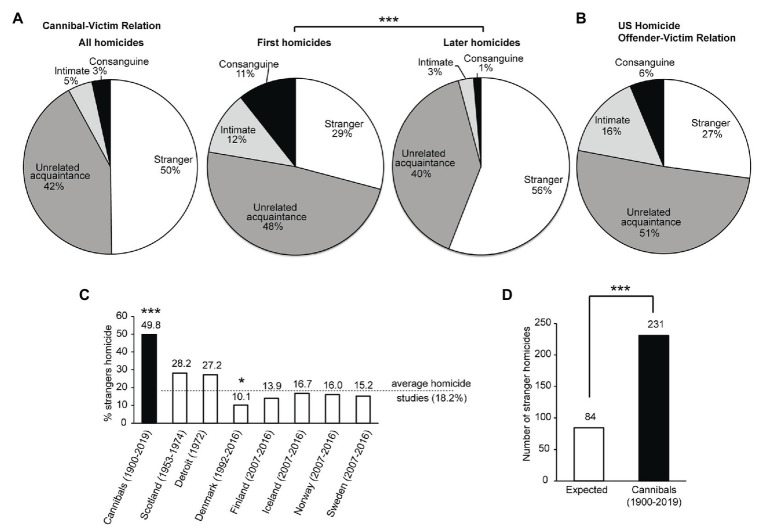
Offender-victim relationships of cannibalistic homicides and other homicides. (A) Offender-victim relationships in homicides of cannibalistic offenders, for all their homicides, only their first homicides, and the later homicides. There is a difference in offender-victim relationship between the first and later homicides [X
2(3) = 42.94, p < 0.001]. (B) Offender-victim relationships in all Detroit homicides (Daly and Wilson, 1982). (C) Fraction of homicides of strangers in cannibalistic offenses (this study) and other homicide studies (Gillies, 1976; Daly and Wilson, 1982; Lehti et al., 2019; Thomsen et al., 2019). The fraction of stranger homicides is different between cannibals and conventional homicides in other countries [X
2(7) = 52.2, p < 0.001, post-hoc pairwise comparison X
2 = 49.8, p < 0.001 for cannibalistic homicides and X
2 = 7.5, p = 0.03 for homicides in Denmark, others n.s., fdr adjusted]. See also Supplementary Data Sheet 4. (D) Expected and observed number of cannibalistic homicides on strangers, based on the average percentages from other homicide studies in C and the total number of cannibalistic homicides with a known offender-victim relationship in this study. The observed number of stranger victims in cannibalistic cases is lower than expected [X
2(1) = 321.4, p < 0.001].